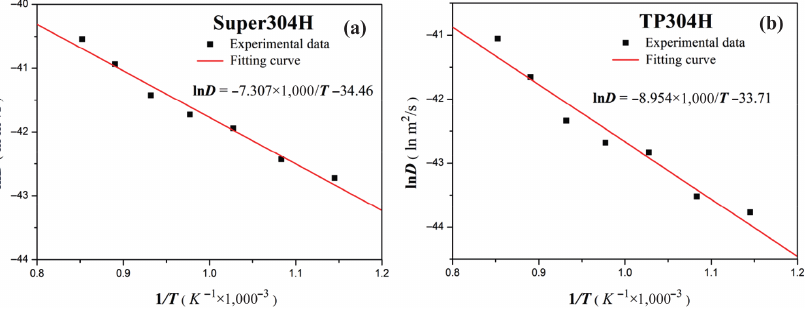
Figure 6: The linear relationship between ln D and 1/ T of the Super304H (a) and TP304H (b)